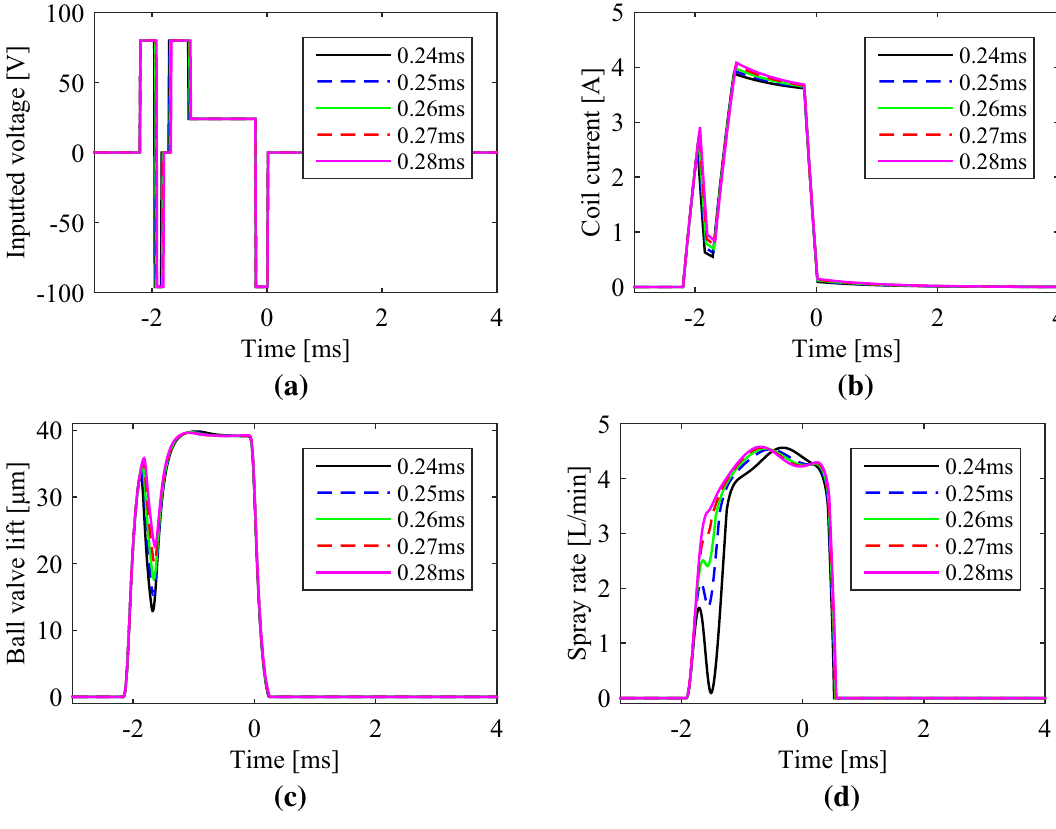
Figure 9. Boot shape injections with different open time in the pilot spray segment from 0.24 to 0.28 ms: ( a ) driving voltage; ( b ) coil current; ( c ) ball valve lift; ( d ) spray